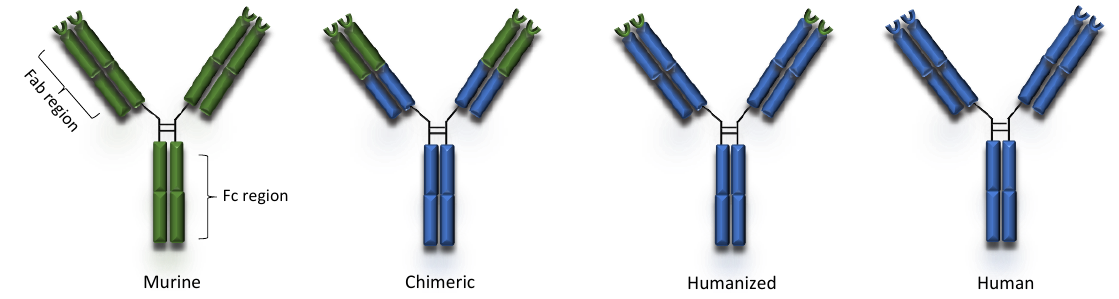
Figure 1. Types of monoclonal antibodies.